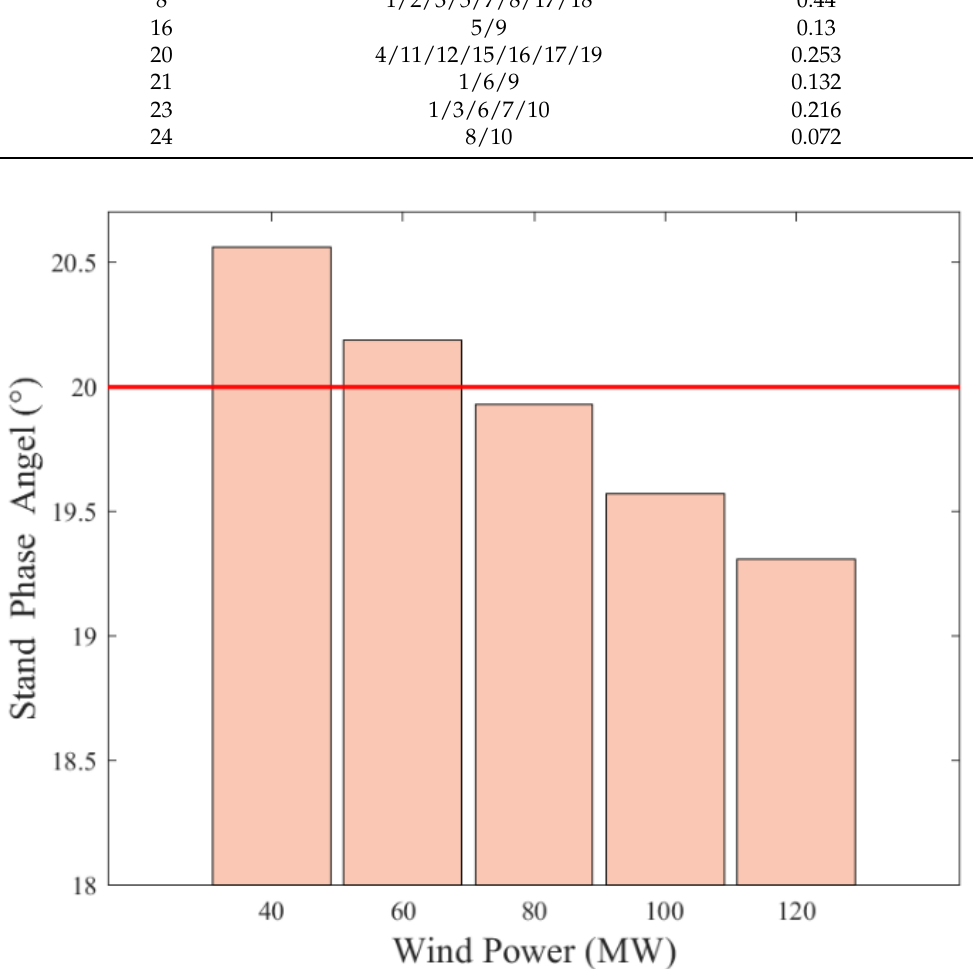
Figure 12. Closing angle value under different wind-power output with the deterministic optimiza- tion scheme.